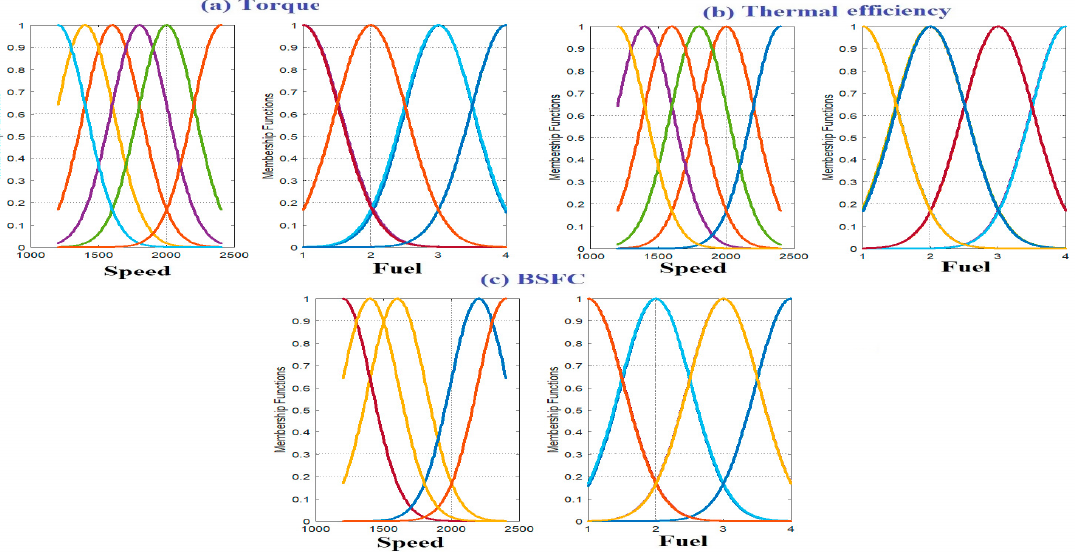
Figure 10. The membership functions of fuzzy models; (a) BT, (b) BTE, and (c) BSFC. (Each color represents fuzzy membership function).